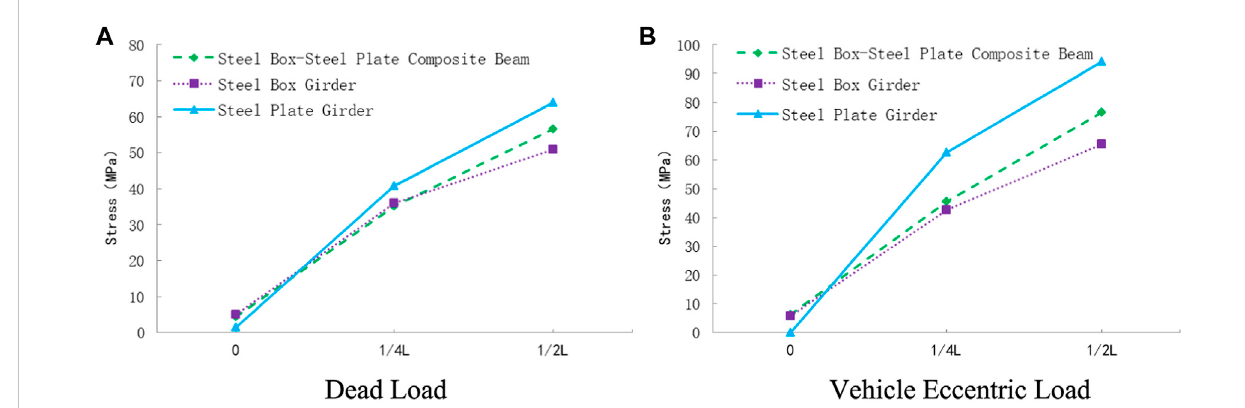
Comparison of normal stress of bottom of straight girder.